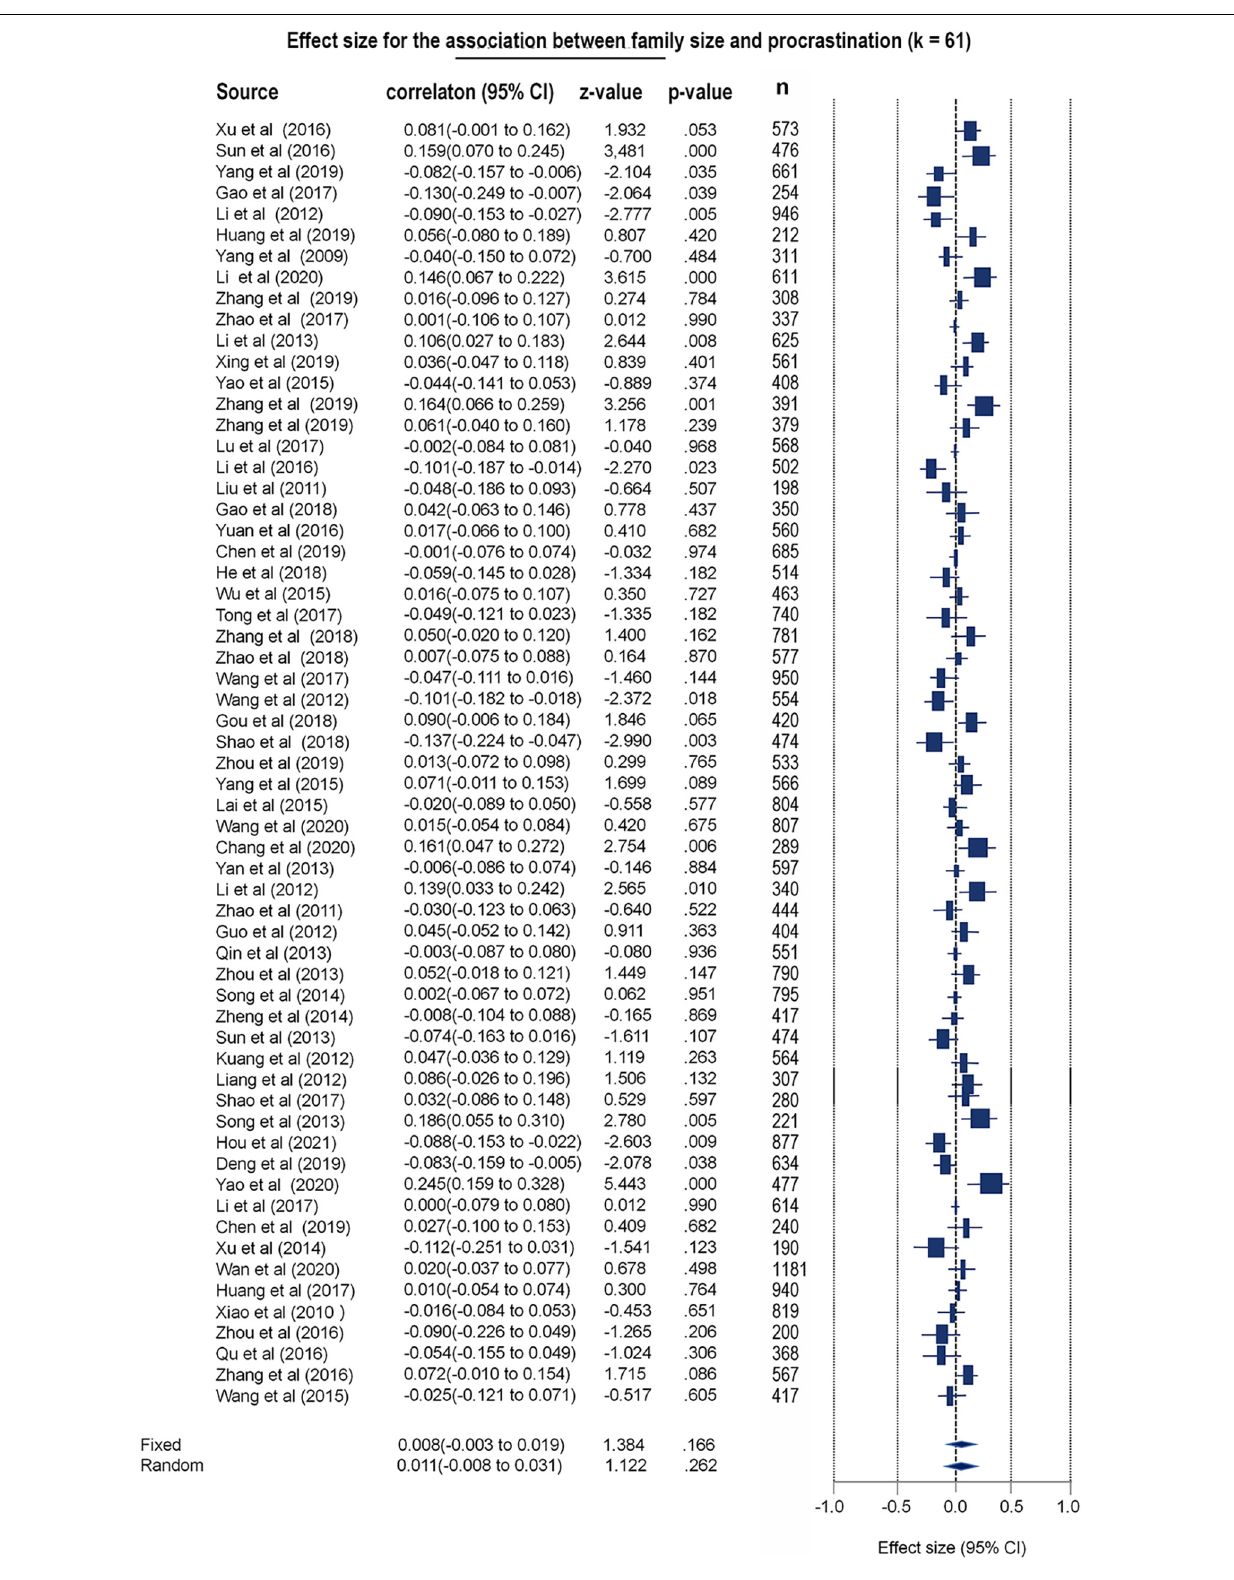
FIGURE 5 | Forest plot for the meta-analytic results toward family size differences of procrastination.